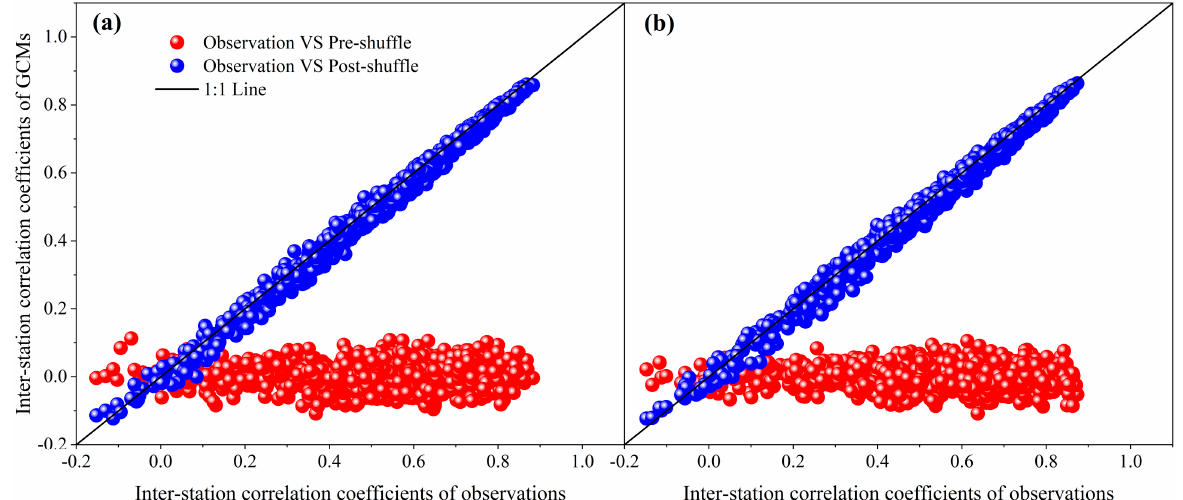
Figure 5. Inter-station spatial correlation coefficient calculated from daily rainfall scatter plots of data before shuffling (pre-shuffle, before using the shuffle procedure), data after shuffling (post-shuffle, after using the shuffle procedure), and observed data for ( a ) CMIP5-MME versus (VS) observations and ( b ) CMIP6-MME VS observations. The inter-station spatial correlation coefficients were calculated from the daily precipitation.